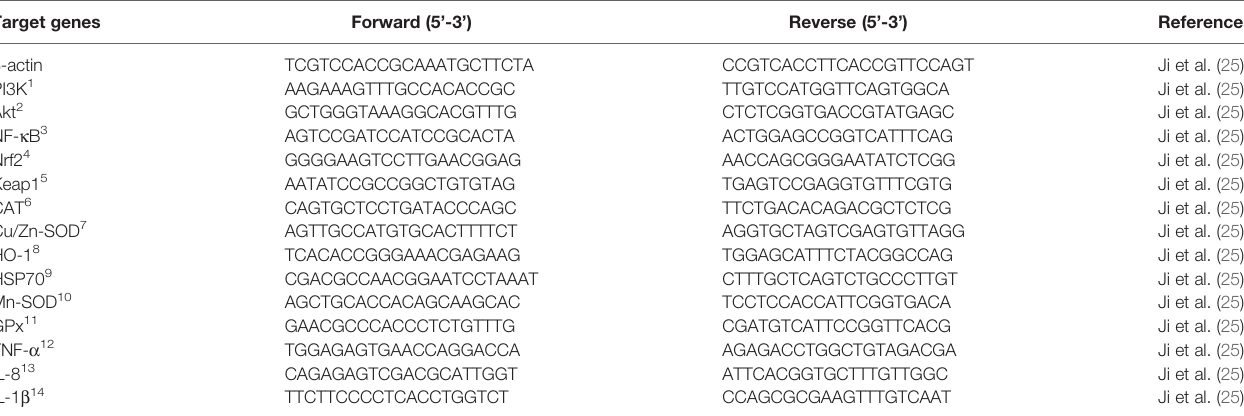
TABLE 3 | Primer sequence for